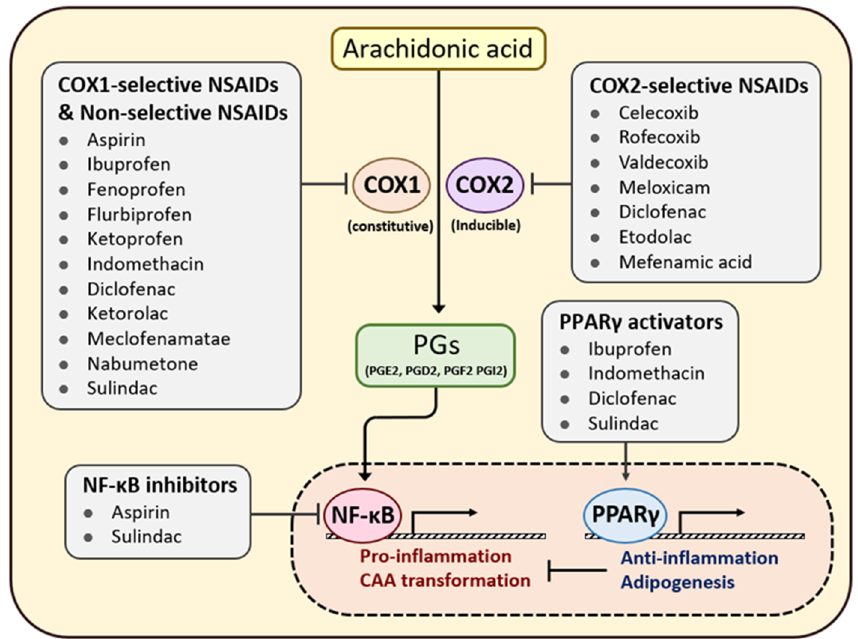
Figure 5. Suppression of NF- κ B-mediated adipocyte transformation via NSAID treatment. COX